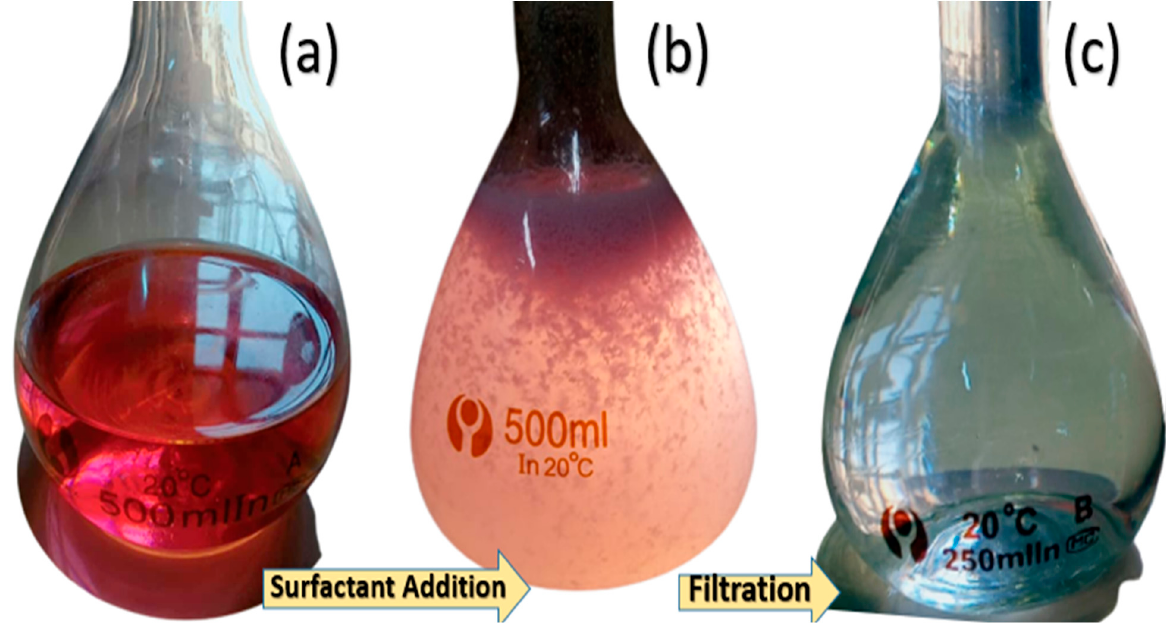
of Co 2+ , ( b ) micelles formation, ( c ) after